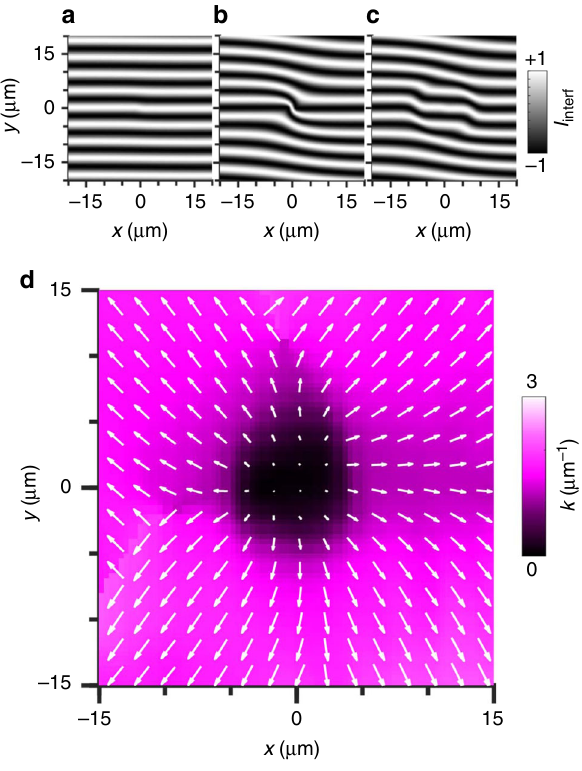
Fig. 4 Spatial pattern of IX momentum k . a – c Simulation of IX shift- interference pattern for k = 0.1 μ m − 1 ( a ), for k = 1.5 μ m − 1 ( b ), and for k = 0.1 μ m − 1 at r < r k and k = 1.5 μ m − 1 at r > r k ( c ). r k = 8 μ m. δ x = 2 μ m. IXs propagate away from the origin. d Pattern of k extracted from shift- interferometry measurements with 2 μ m shift in ^ x and ^ y . The direction and size of arrows indicate k direction and magnitude, respectively. P = 2.9 mW. T bath = 0.1 K. The data correspond to LBS 6